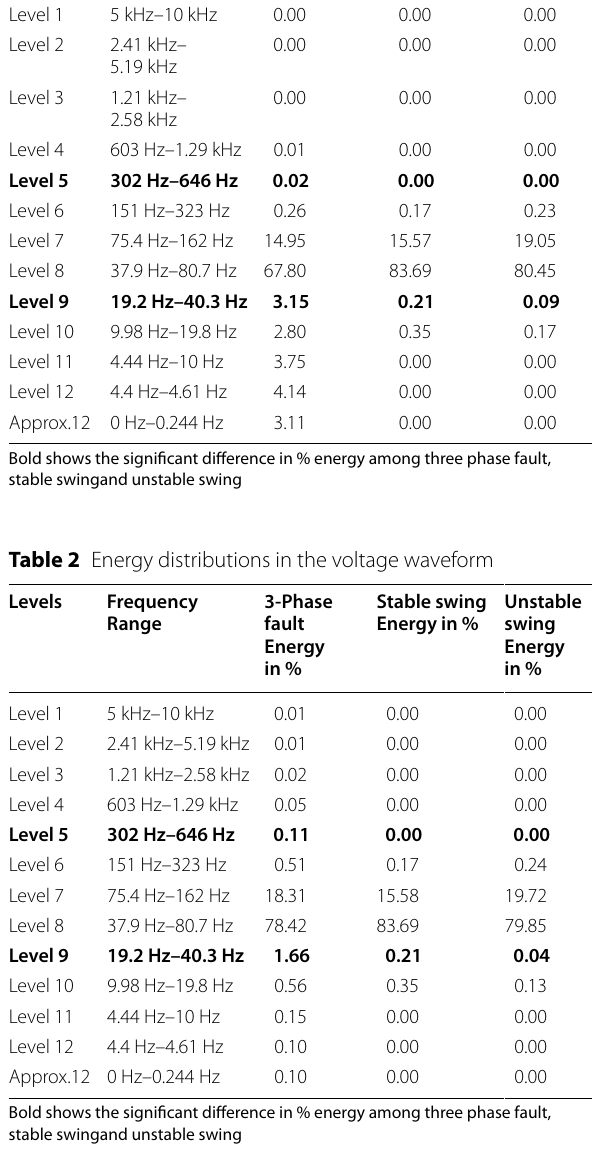
Table 1 Energy distributions in the current waveform Levels